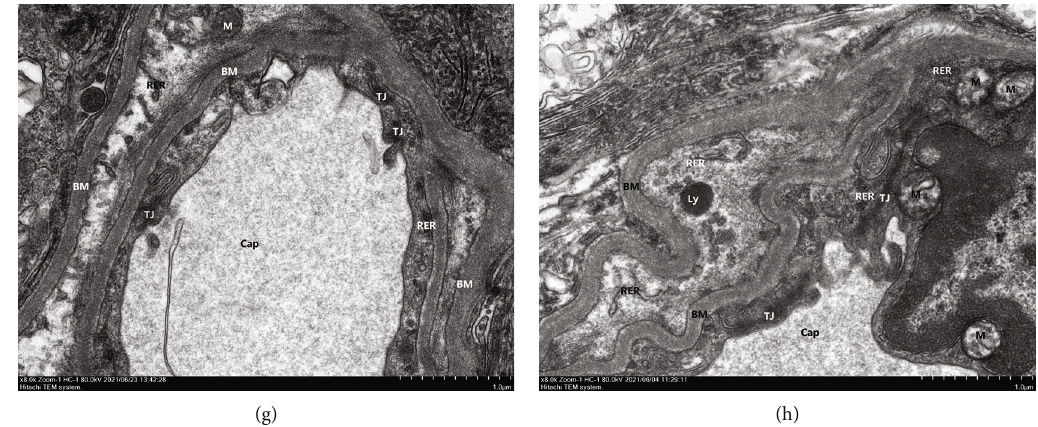
Figure 3: Ultrastructural changes in the retina of mice in each group. (a – d) Normal group, DM group, DU600 group, and DU1000 group ( × 2500). (e – h) The corresponding high magni fi cation fi eld of view for groups (a – d) ( ×